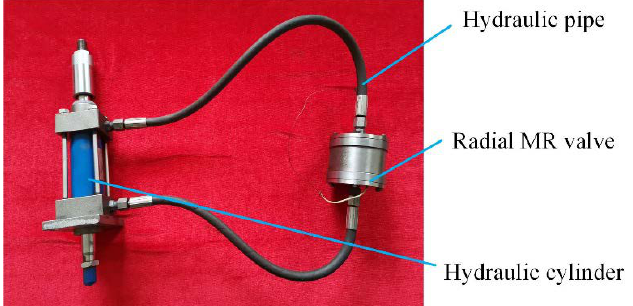
Figure 26. Prototype of the optimal radial MR valve controlled cylinder system.